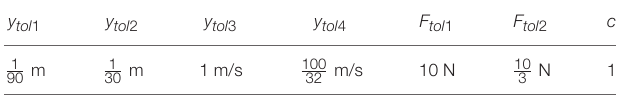
TABLE A1 | Experimental values of the OIC coefficients.